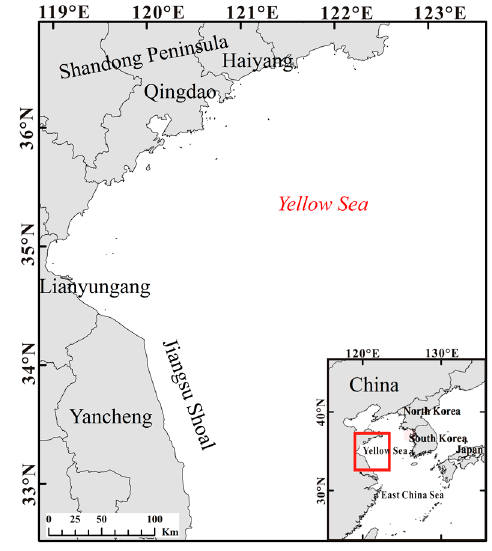
Figure 1. Map of the study area in the Southern Yellow Sea, China.